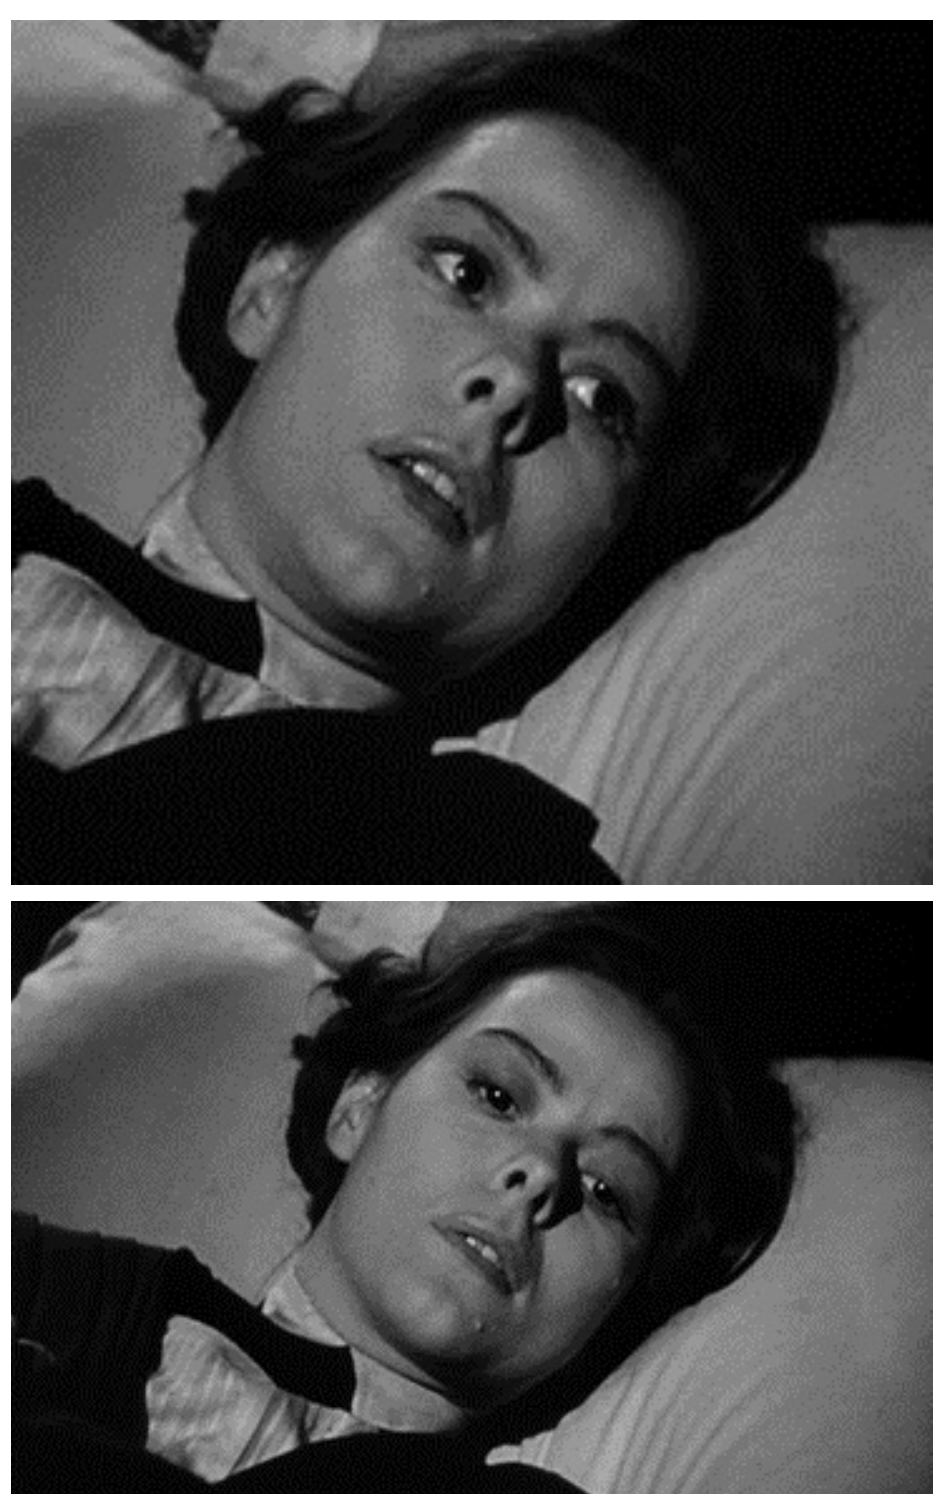
Figure 10: Script: LUCY: ‘If there’s ever anything I can do for . . . ’ she falters, lowers her eyes and looks